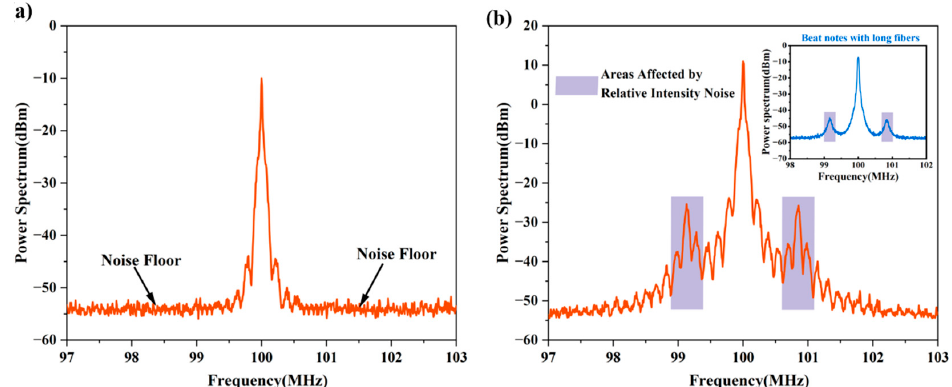
Figure 8. Plots of the self-heterodyne signal PSD taken for a power-scalable fiber laser (CONNET, CoSF-D-YB-M) for output powers of 1 mW ( a ) and 10 mW ( b ) (the Lorentzian-shaped spectrum as recorded using a long length of delay fiber (50 km) is shown as the